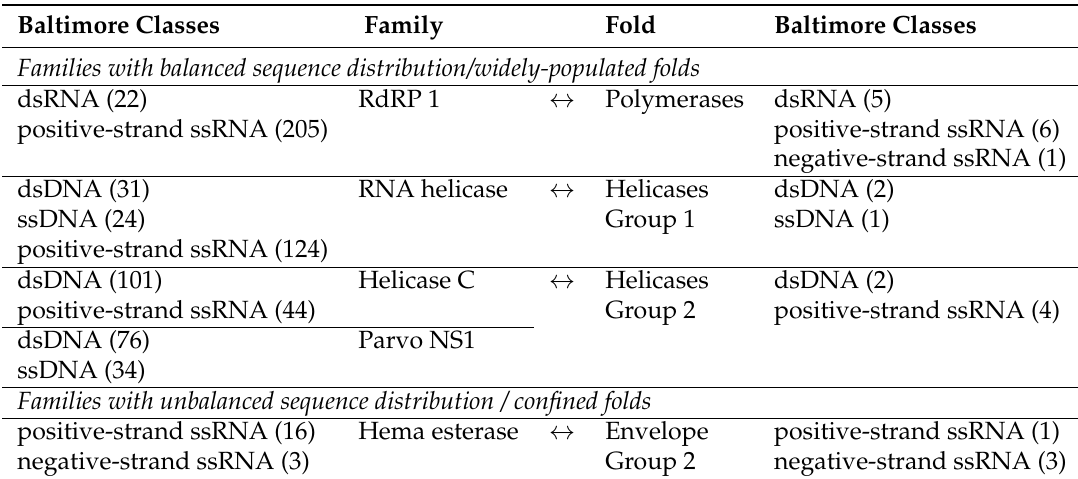
Table 3. Overlapping protein families and folds identified in the sequence and structure comparison, respectively. The number of proteins from each Baltimore class is given in